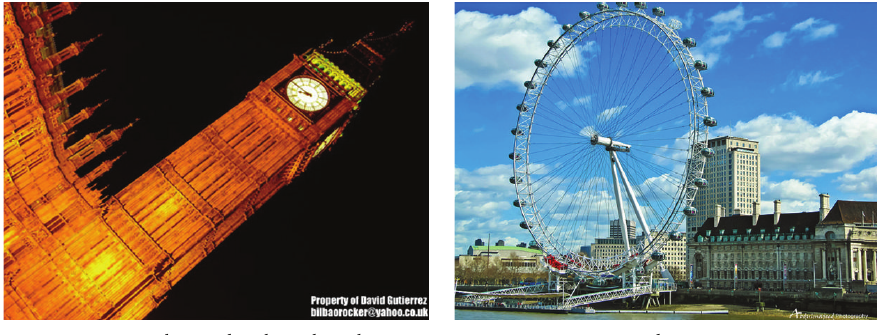
Figure 2: The illustration of a pair of images from